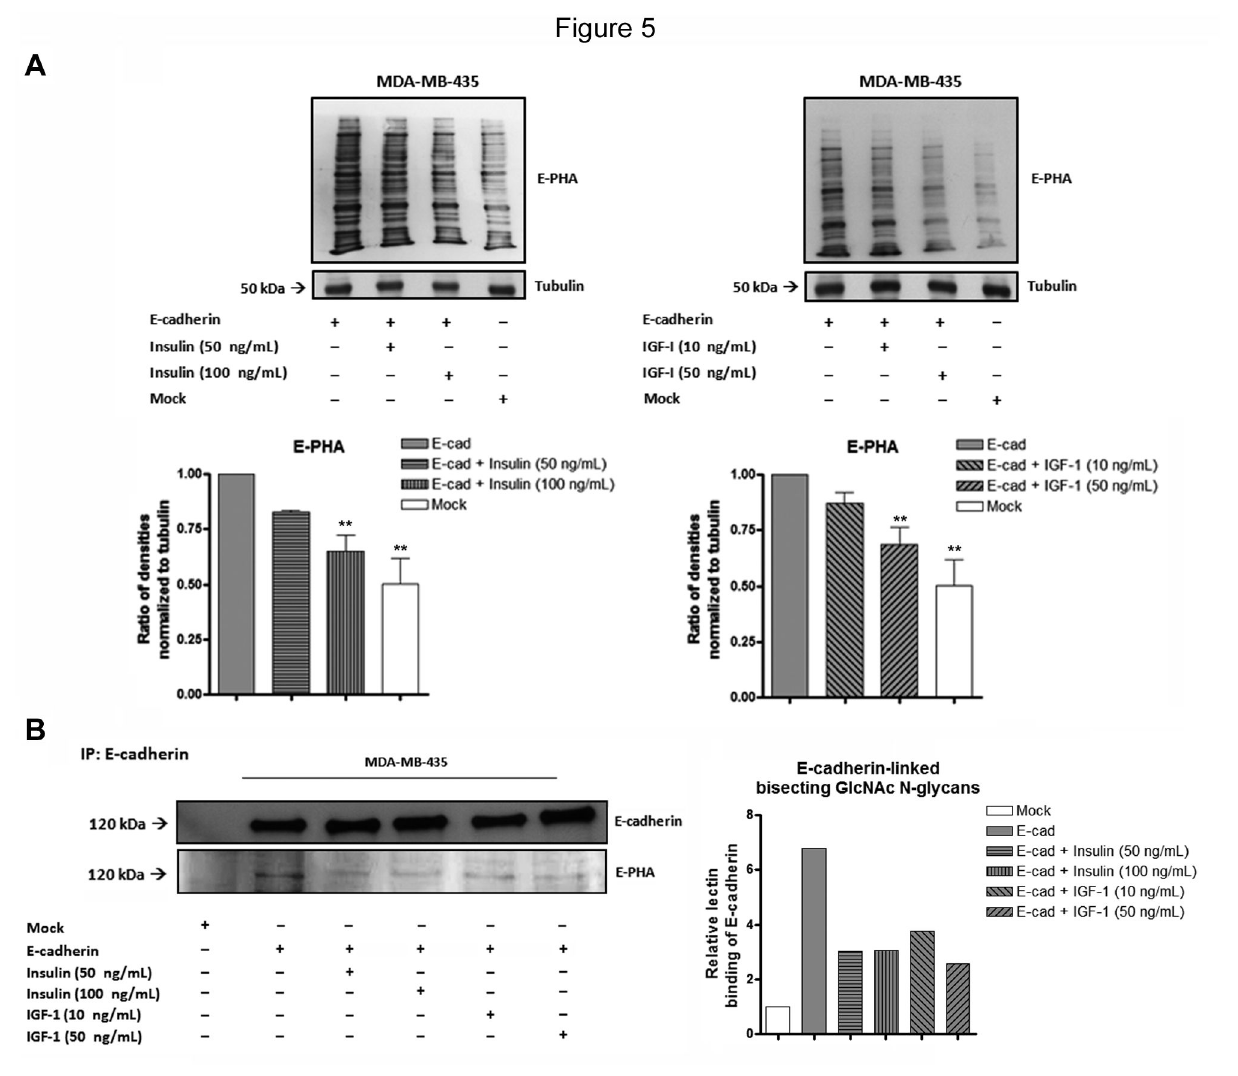
Figure 5. Effects of insulin and IGF-I stimulation on the expression levels of bisecting GlcNAc N -glycans, in general and specifically on E-cadherin. (A) Total cell lysates from MDA-MB-435+mock, MDA-MB-435+E-cad and MDA-MB-435+E-cad stimulated (24h) with insulin or IGF-1 were obtained and analyzed by Lectin blot for E-PHA. The bar graphs show the relative amount of bisecting GlcNAc N -glycans levels in the whole protein lysate. MDA-MB-435+E-cad cells stimulated with insulin (100 ng/mL) and IGF-I (50 ng/mL) showed a significant decrease of the overall levels of bisecting GlcNAc N-glycans. The values were normalized to tubulin. Error bars indicate the means + S.E.M. (n = 3). ** = P < 0.01 ANOVA test. (B) Total cell lysates from MDA- MB-435+mock, MDA-MB-435+E-cad and MDA-MB-435+E-cad stimulated (24h) with insulin or IGF-1 were obtained and immunoprecipitated using E-cadherin antibody. The immunoprecipitates were analyzed by Western blot for E-cadherin and Lectin blot for E-PHA. The bar graphs show the relative amount of E-cadherin-linked bisecting GlcNAc N -glycans levels. Activation of insulin and IGF-I signaling pathway led to a decreased modification of E-cadherin with bisecting GlcNAc N-glycan structures. doi: